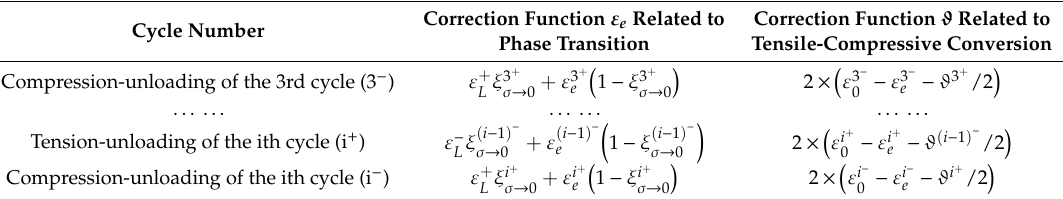
Figure 2. Uniaxial tensile-compressive loading charts with peak stresses of σ + p under tension and σ − p